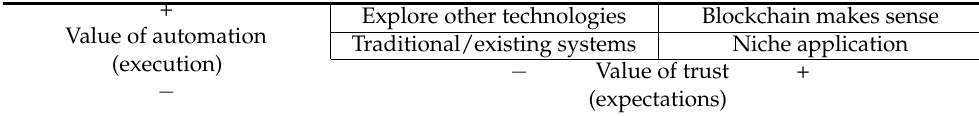
Table 4. Value of trust and automation matrix for blockchain (adapted from [18,24,49]). + Value of